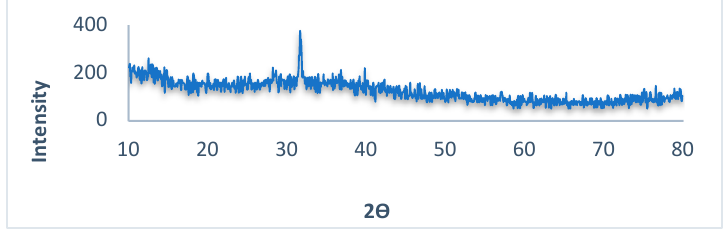
Figure 2. X-ray diffraction pattern of zirconium magnetic nanocomposite.